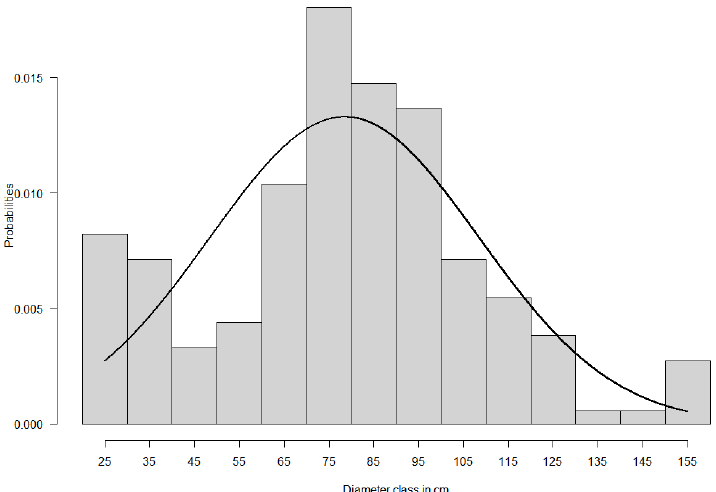
Figure 2. Diameter distribution of C. gabunensis stems (DBH > 20 cm) in the FMUs 2 and 3 (398,169 ha) managed by Precious Woods CEB logging company in south-eastern Gabon; (i) the x-axis shows 14 central values of the diameter classes ([20–30], [30–40], . . . , [150–160] cm), (ii) the y-axis represents the probabilities of the normal distribution for each diameter